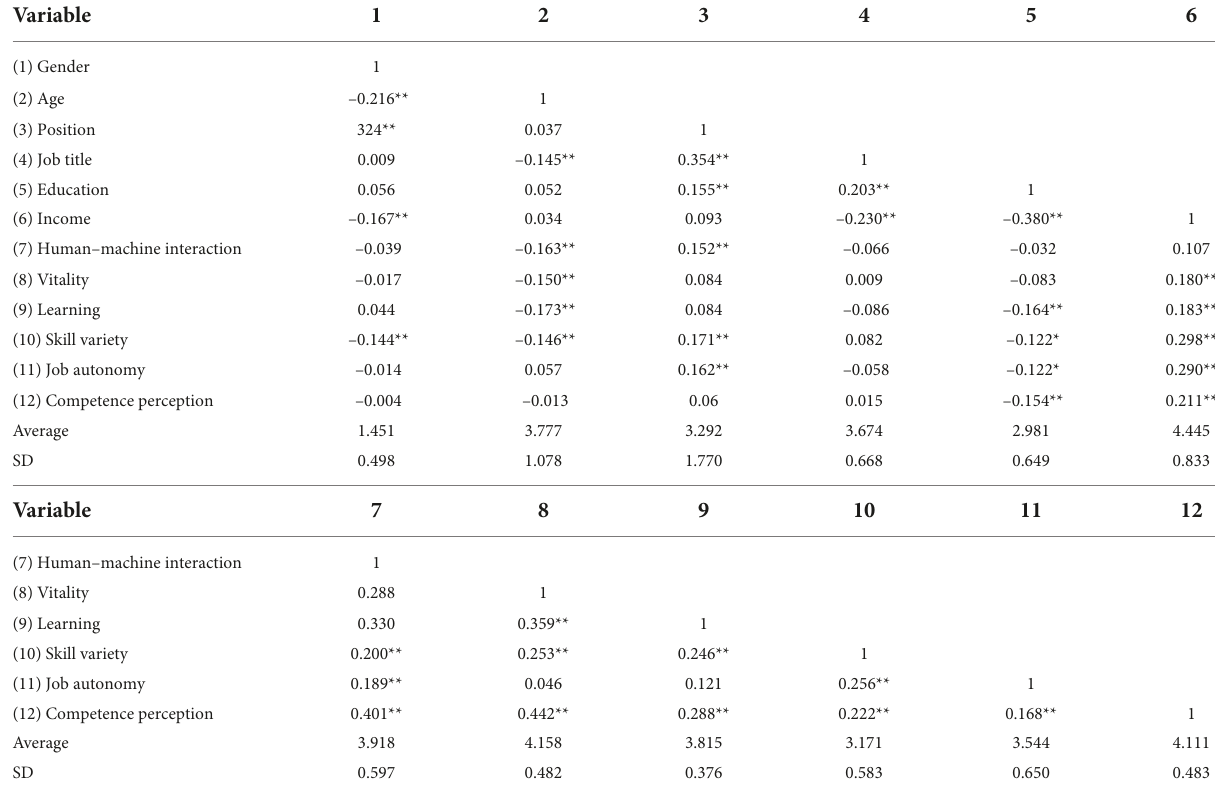
TABLE 3 Descriptive statistics and correlation analysis.